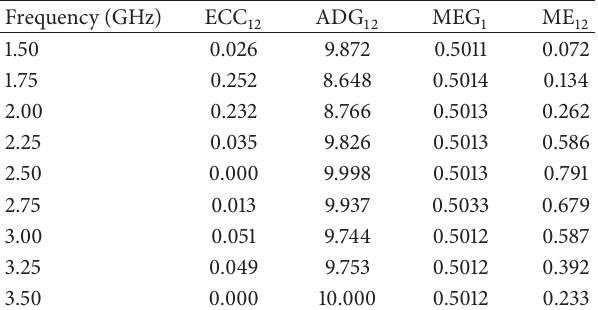
Table 2: Diversity and multiplexing